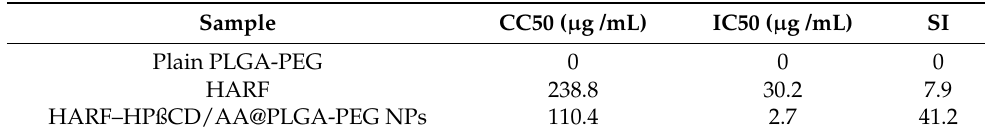
Table 4. Antiviral activity of HARF and HARF–HPßCD/AA@PLGA-PEG NPs against influenza A (H1N1)